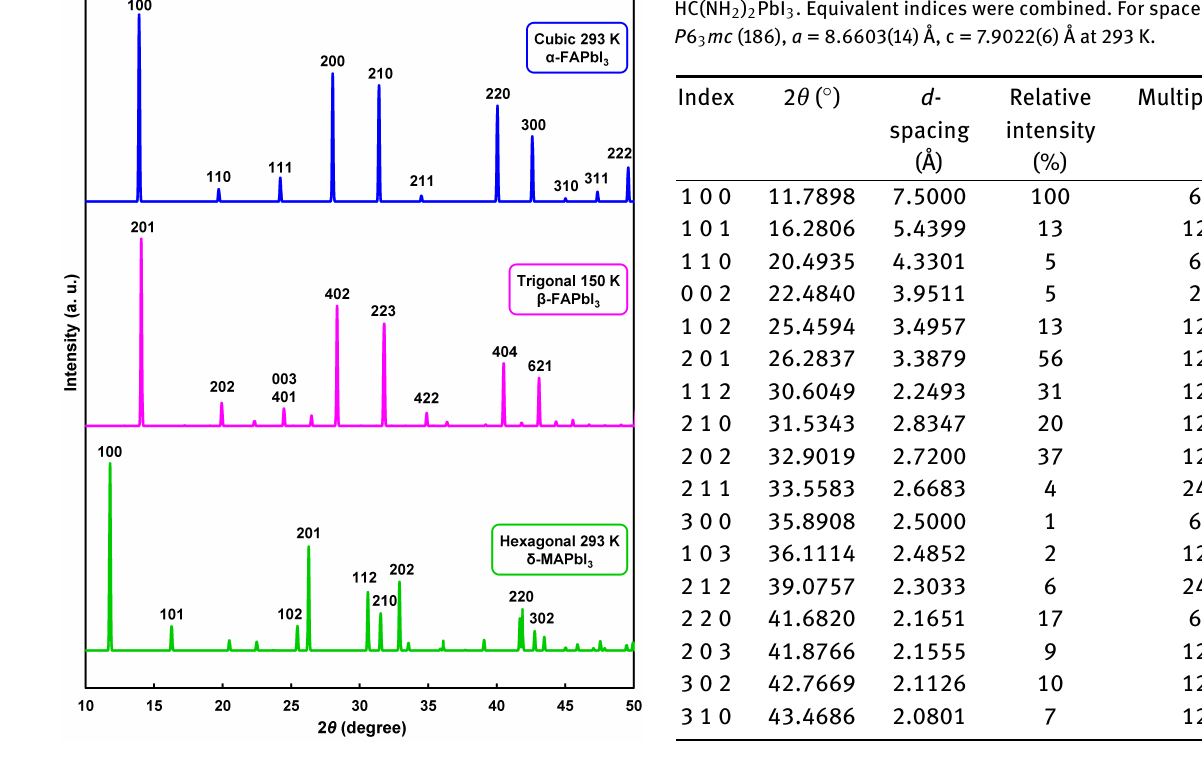
Figure 18: Calculated X-ray diffraction patterns of α -, β -, and δ - HC(NH 2 ) 2 PbI 3 .